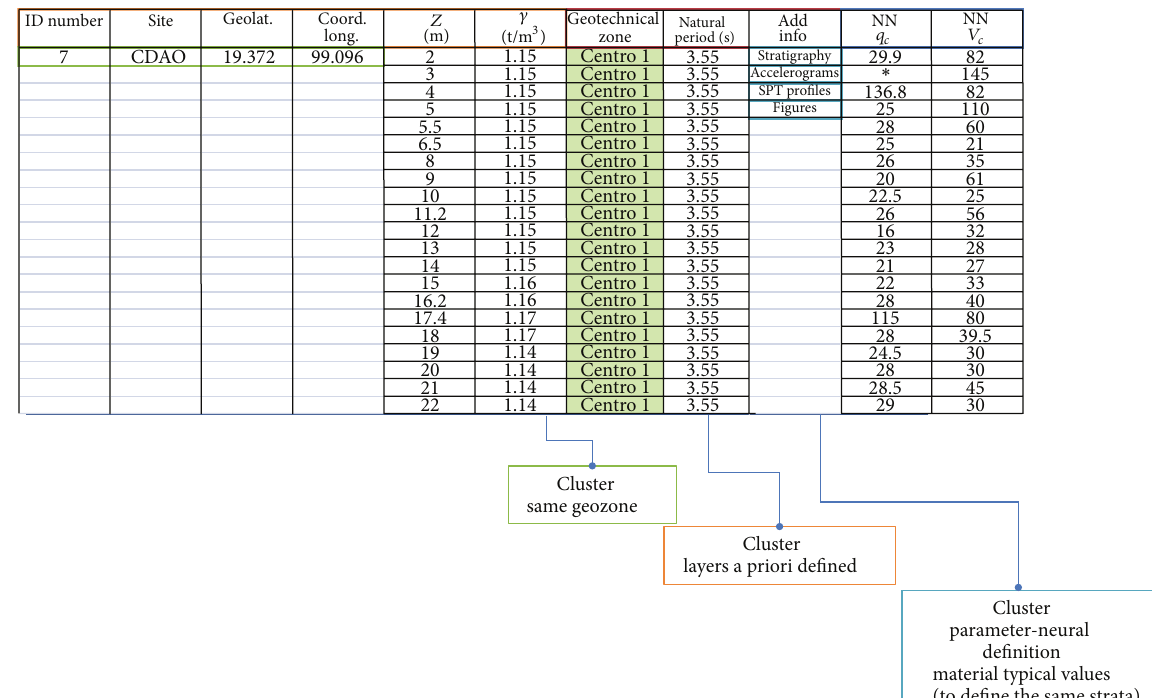
Figure 5: Schematic representation of Table 3: “real” and “virtual” borings to construct the stratigraphies or the 3D